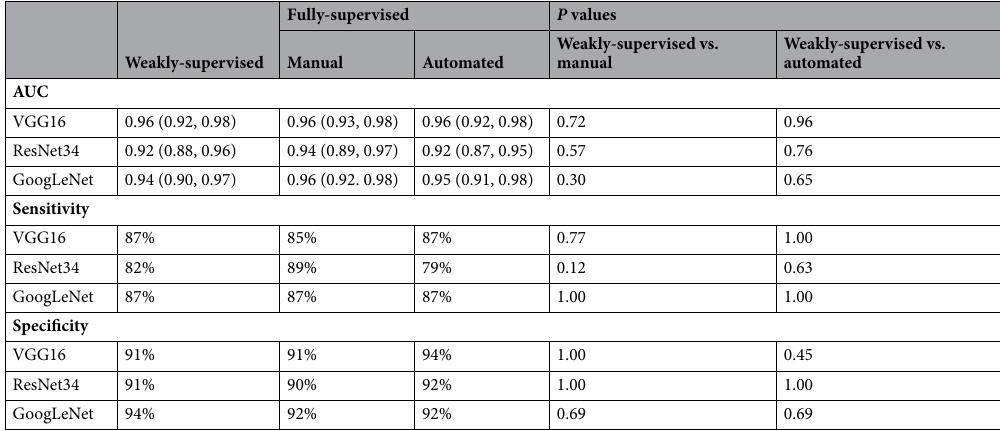
Table 2. Diagnostic performance metrics of weakly-supervised and fully-supervised deep learning algorithms in internal validation set. 95% confidence intervals in parenthesis.